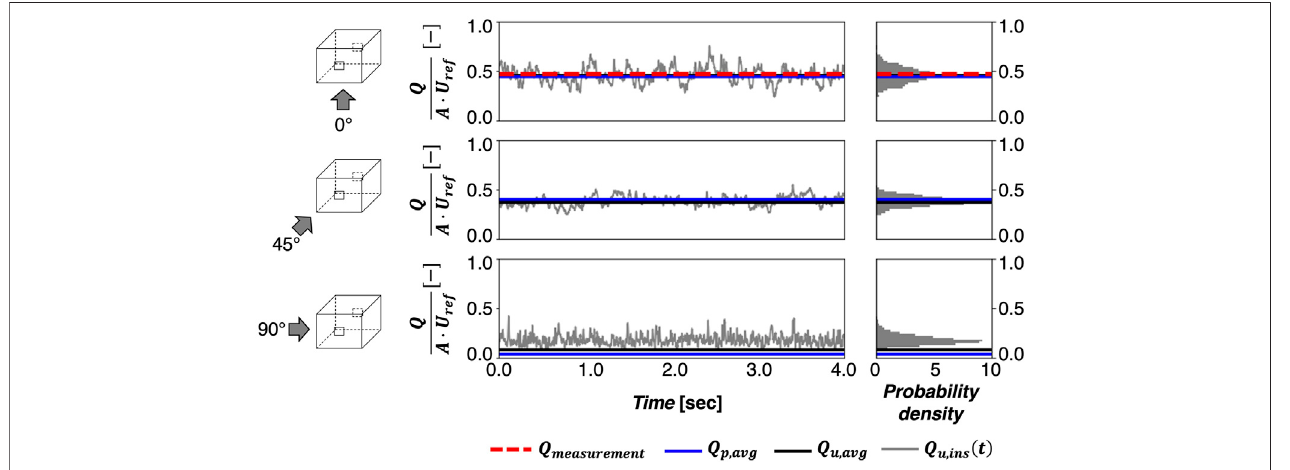
FIGURE 7 | LES predictions of ventilation rate using velocity (left) and pressure (right) for the 0 ° (top), 45 ° (middle), and 90 ° (bottom) wind directions.